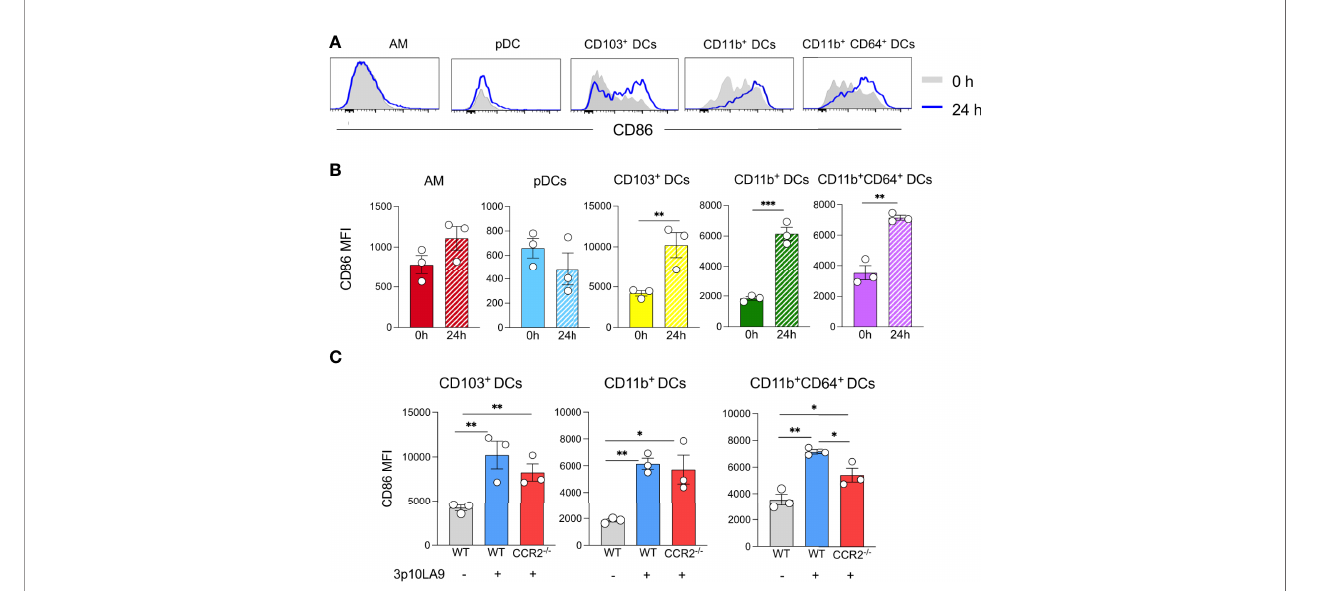
FIGURE 6 | Intranasal dsRNA hairpin delivery induces DC maturation in the lungs. (A) Representative fl ow cytometry histogram showing the expression levels of the costimulatory molecule CD86 on AM, pDCs, CD103 + DCs, CD11b + DCs, CD11b + CD64 + DCs. Mice were intranasally inoculated and lungs collected 24 h later. Grey shaded histogram: untreated; blue line histogram: 3p10LA9. (B) Bar chart representing the mean of fl uorescence intensity of CD86 on pulmonary AM, pDCs, CD103 + DCs, CD11b + DCs, CD11b + CD64 + DCs from 0h untreated and 24 h treated WT mice. The error bars represent the SEM (n= 3 mice). ** P <0.01; *** P <0.001; two-tailed t-Student ’ s Test. These data are representative of three independent experiments (C) Bar chart representing the mean of fl uorescence intensity of CD86 on pulmonary CD103 + DCs, CD11b + DCs, and CD11b + CD64 + DCs from untreated and 24 h treated WT and CCR2 -/- mice. Grey bars: WT untreated; blue bars: WT mice, 24 h intranasal 3p10LA9 delivery; red bars: CCR2 -/- mice, 24 h intranasal 3p10LA9 delivery; The error bars represent the SEM (n= 3 mice). * P <0.05; ** P <0.01; two-tailed t-Student ’ s